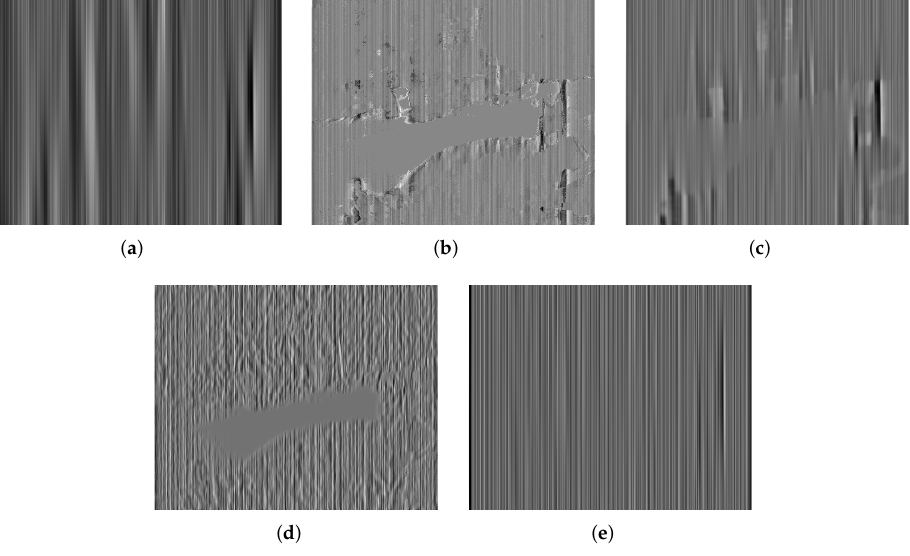
Figure 10. NUN results for Street. ( a ) WTSF; ( b ) MIRE; ( c ) GIF; ( d ) CNN; ( e )